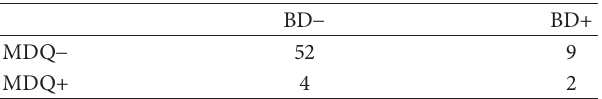
Table 1: MDQ-positive patients (standard cut-off ∗ ) and diagnosis of BD.